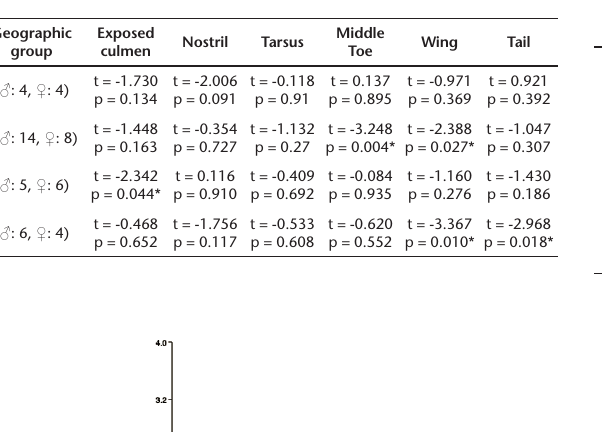
Table 3. Student t-test comparing males and females of each geo- graphic group with more than four individuals for each sex. Asterisks indicates significant differences between both sexes at p < 0.05.